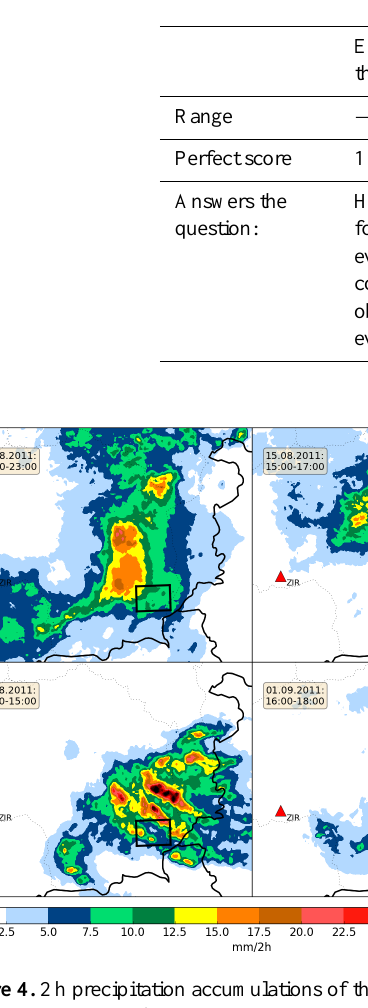
Table 2. Skill scores used for validation (Wilks, 2006). See also WMO Joint Working Group on Forecast Verification Research, e.g.: http: //www.cawcr.gov.au/projects/verification/.